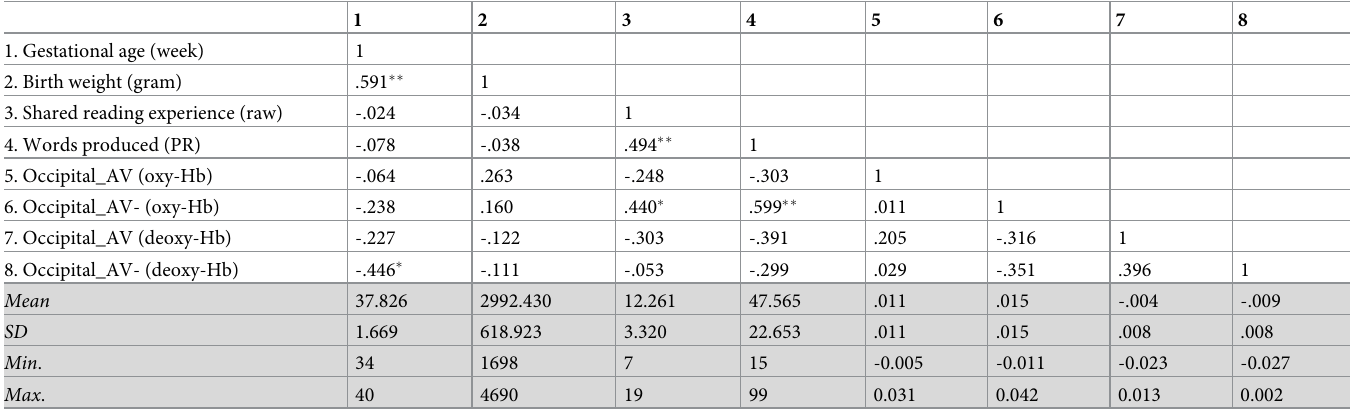
Table 1. Correlation coefficients ( r ) between measures and descriptive